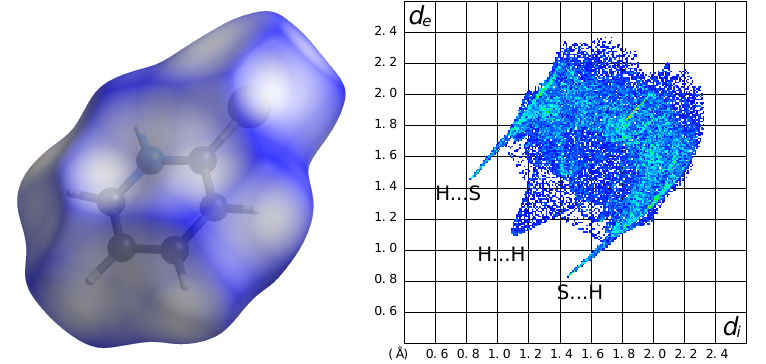
Figure 3. ( Left ) Hirshfeld surface of (I) as calculated with CrystalExplorer (version 21.5) [21]. The colour of the surface is determined by the normalized contact distance d norm = d | e | + d | i | . ( Right ) Fingerprint plot derived from the Hirshfeld surface; d i is the interior and d e the exterior distance.